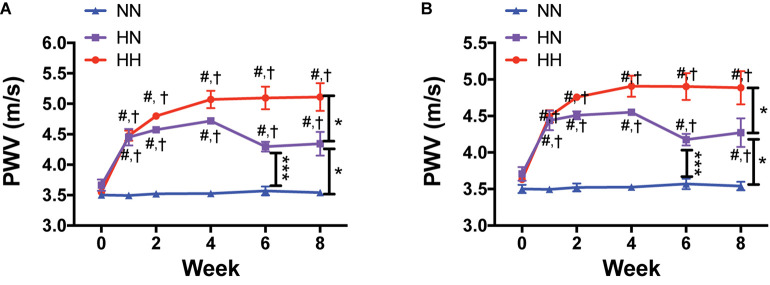
In vivo vascular stiffness increases with angII infusion and is partially reversed by restoration of normal blood pressure (BP). (A) Longitudinal pulse wave velocity (PWV) as an index of in vivo vascular stiffness in HH, HN, and NN cohorts. (B) PWV corrected for MAP. n = 10 mice per group. ∗p < 0.05, ∗∗∗p < 0.001 between indicated groups; #p < 0.001 for both HH and HN groups vs. NN at matched time point; †p < 0.001 for HH and HN groups vs. corresponding baseline (time 0) by repeated measures 2-way ANOVA with Bonferroni post hoc analysis.